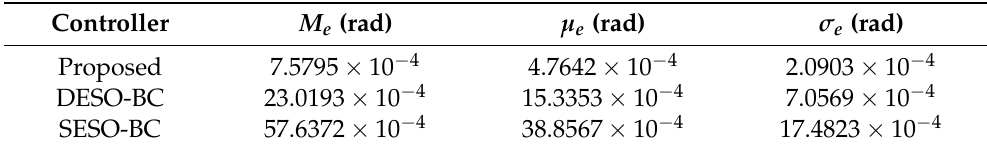
Table 2. Performance indexes of all controllers in the case of step reference trajectory in the steady- state